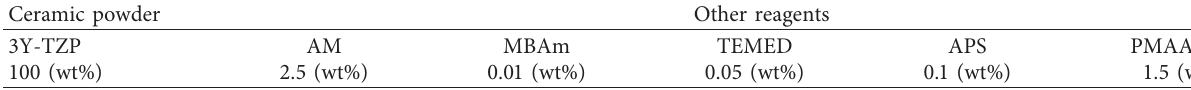
Table 1: The ratio of reagents.